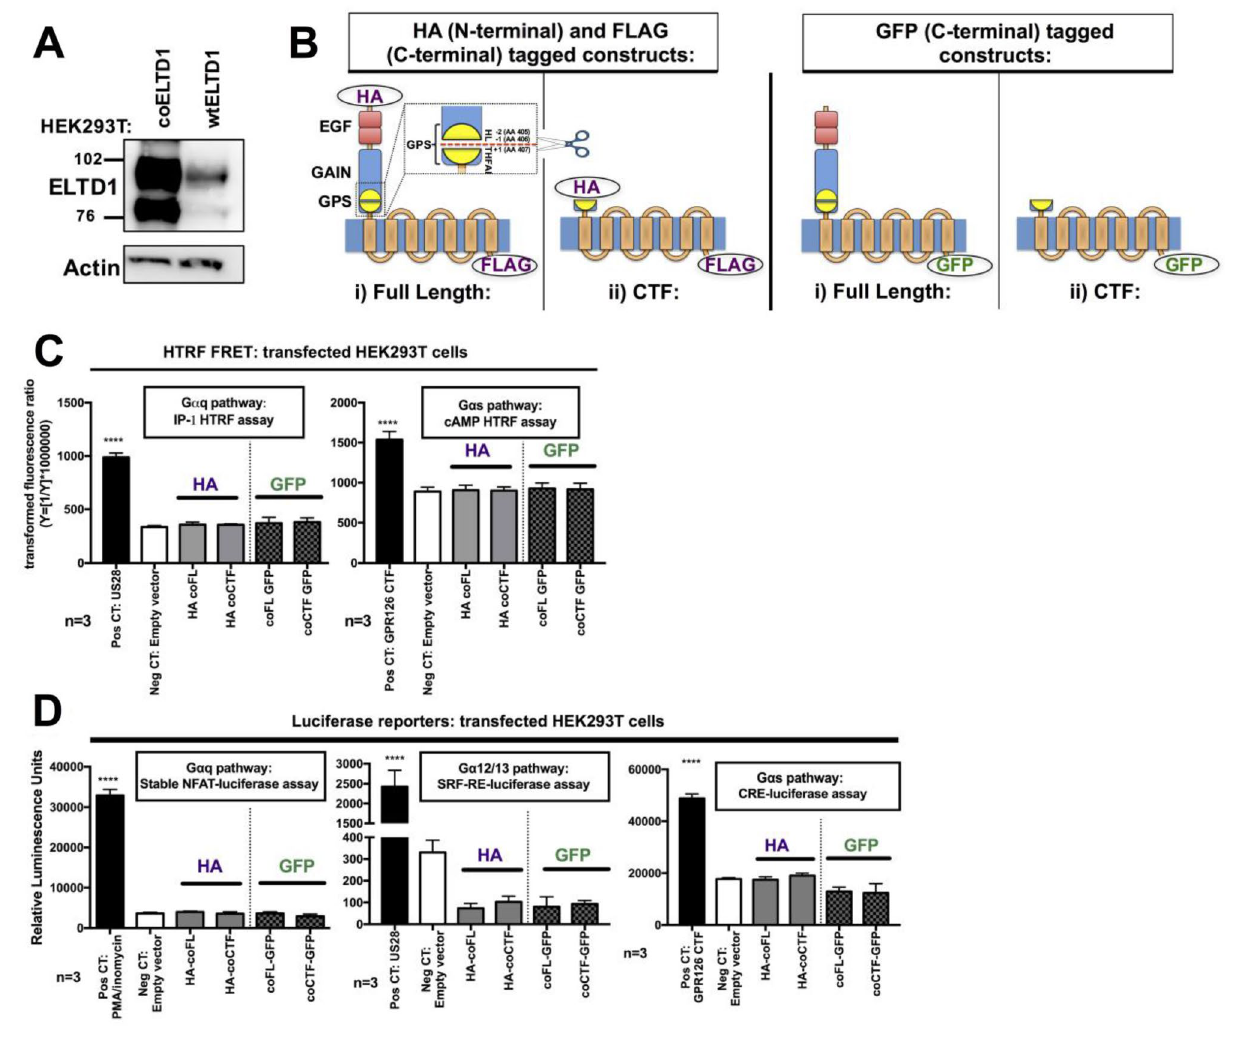
Figure 1. Codon optimisation increases ADGRL4/ELTD1 expression but FL and CTF forms of ADGRL4/ ELTD1 do not activate canonical GPCR signalling. ( A ) Representative Western blot of co FL ADGRL4/ELTD1 compared to wt FL ADGRL4/ELTD1. ( B ) ADGRL4/ELTD1 signalling construct design showing FL and CTF forms with different tagging strategies. ( C ) Gαq HTRF FRET assays in ADGRL4/ELTD1 transiently transfected HEK293T cells. Positive controls used were US28 for Gαq ( p < 0.0001) and the CTF form of ADGRLG6/GPR126 for Gαs ( p < 0.0001) ( D ) Gαq, Gα12/13, Gαs luciferase assays in ADGRL4/ELTD1 transiently transfected HEK293T cells. Positive controls used were PMA/ionomycin for Gαq ( p < 0.0001), US28 for Gα12/13 ( p < 0.0001) and the CTF form of GPR126 for Gαs ( p < 0.0001). (Abbreviations: Pos CT = positive control; Neg CT = negative control; FL = full length; wt = wild type; co = codon optimised; CTF = C-terminal fragment; HA = hemagglutinin; GFP = green fluorescent and screening studies with all 21 peptides, subsequent studies focussed on peptides p10-20 (Fig. 2A) as most published Stachel peptides had been of a length within this range. The 11 selected ADGRL4/ELTD1 Stachel pep- tides were then assayed for activation of co FL ADGRL4/ELTD1 transiently transfected in HEK293T cells using luciferase assays corresponding to all canonical GPCR signalling pathways. With peptide insolubility being of concern we wanted to include some additional peptide controls. Thus, phylogeny comparisons were conducted on the predicted GPS sequences of all human aGPCR family members to find the relative with the highest GPS similarity to ADGRL4/ELTD1’s GPS (ADGRA1/GPR123 does not contain a GPS domain and was not included) as it has been shown that aGPCRs that cannot be activated through their own tethered agonist can be induced through closely related Stachel peptides 26 . ADGRD1/GPR133 had the most similar GPS (Fig. 2B) and ADGRG5/ GPR114’s peptide (pGPR114) (Wilde et al., 2016) was chosen as an additional control peptide. Neither of these peptides showed Gαq, Gαs, Gαi, Gα12/13, or Gβγ pathway signalling activity with ADGRL4/ELTD1 (Fig. 2C). Results from HTFR FRET assays performed in similarly transfected HEK293T cells as well as on non-trans- fected HUVECS (which constitutively express WT FL ADGRL4/ELTD1) using all 21 Stachel peptides showed no Gαs or Gαi signalling (Figure S2A-B). In summary, ADGRL4/ELTD1 did not appear to activate any form of canonical GPCR signalling (Fig. 2D).